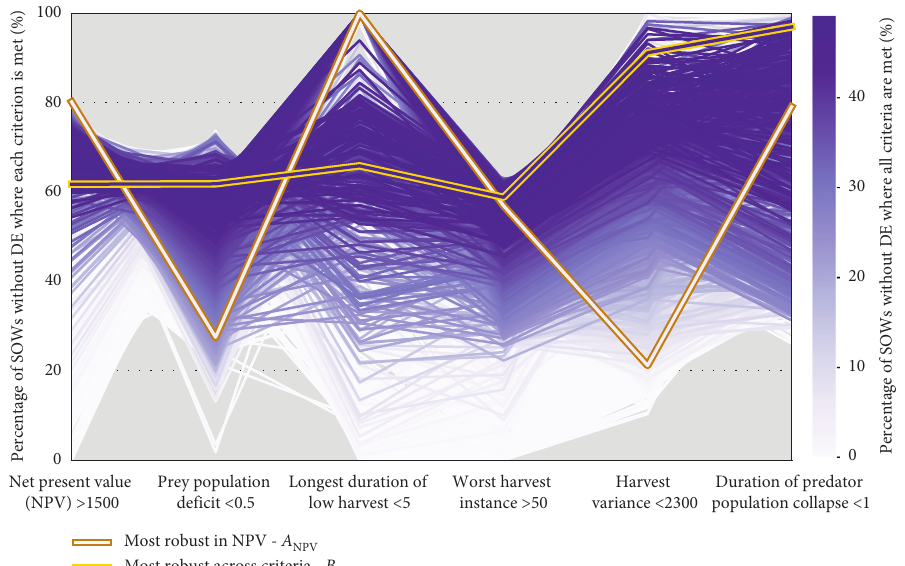
Figure 7: Parallel coordinate plot of satisficing tradeoffs for all identified solutions when applied in the alternative SOWs without de- terministic extinction. Each vertical axis represents the percentage of SOWs in which each solution fulfills each criterion. Each solution is colored based on the percentage of SOWs in which it fulfills all criteria. The two highlighted solutions, A two robustness definitions, meeting criterion 1 and meeting all criteria,